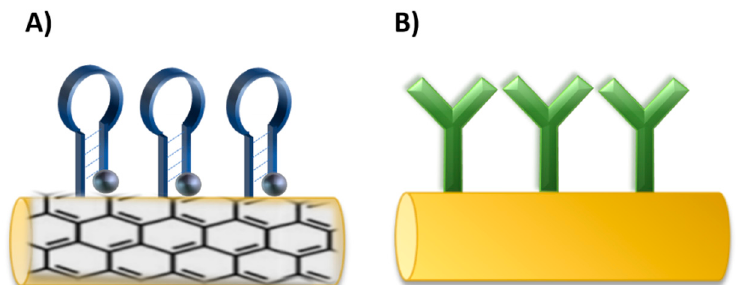
Figure 11. Schematic illustration of immobilization of ( A ) aptamers and ( B ) antibodies on the surface of nano/micromotors.